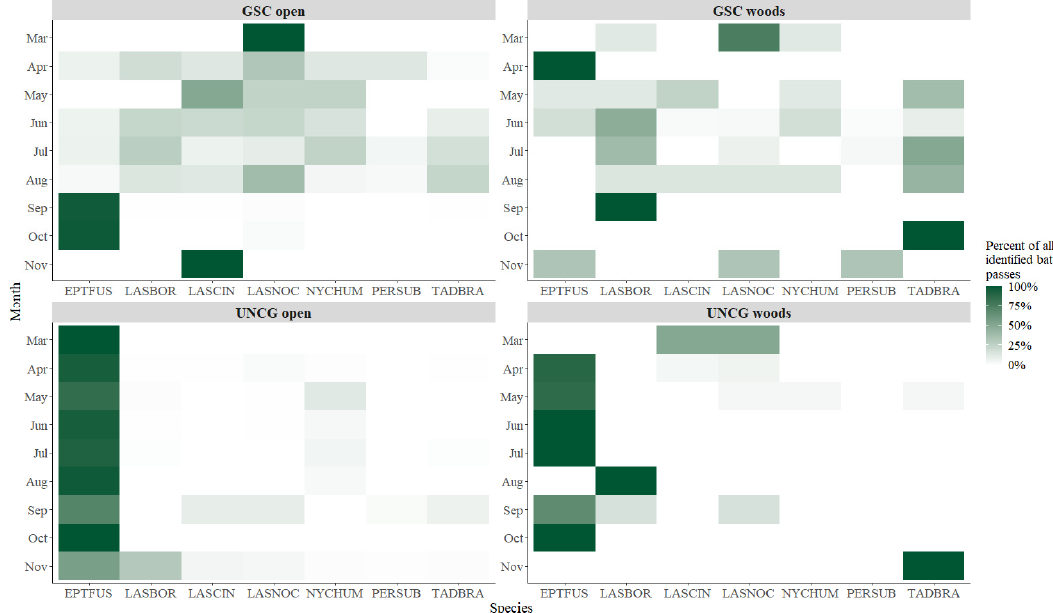
Figure 1. Monthly species-specific bat pass percentage at four sites (Greensboro Science Center / GSC and University of North Carolina Greensboro / UNCG) between 2018 and 2019 in Greensboro, North Carolina, USA.